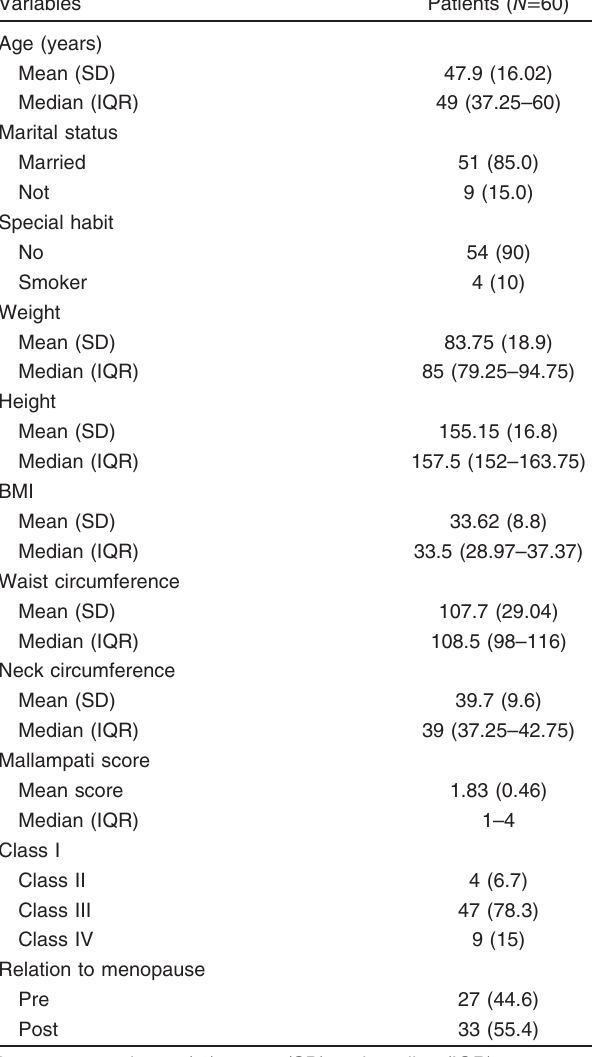
Table 2 STOP-Bang questionnaire and Mallampati score of study